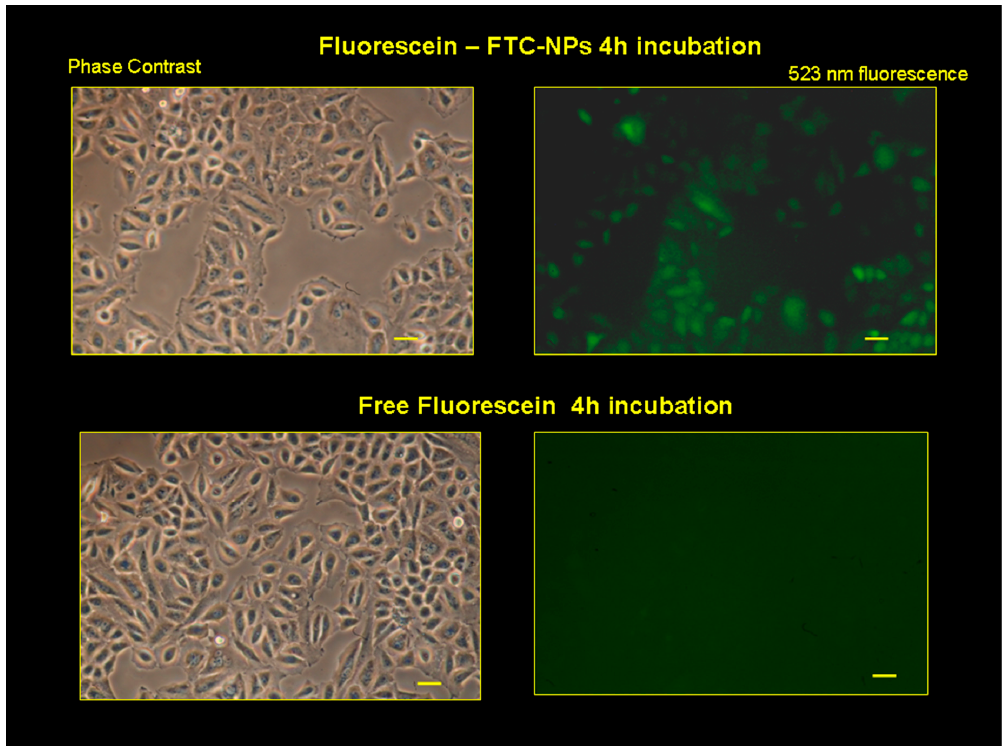
Figure 7. Fluorescence microscopic pictures of HeLa cells after incubation over 4 h with culture medium containing NaFl-loaded FTC-NPs and free NaFl. The fluorescence excitation was at 475 nm, and detection was at 523 nm. The respective phase contrast images are also shown. Scale bar = 50 µm.